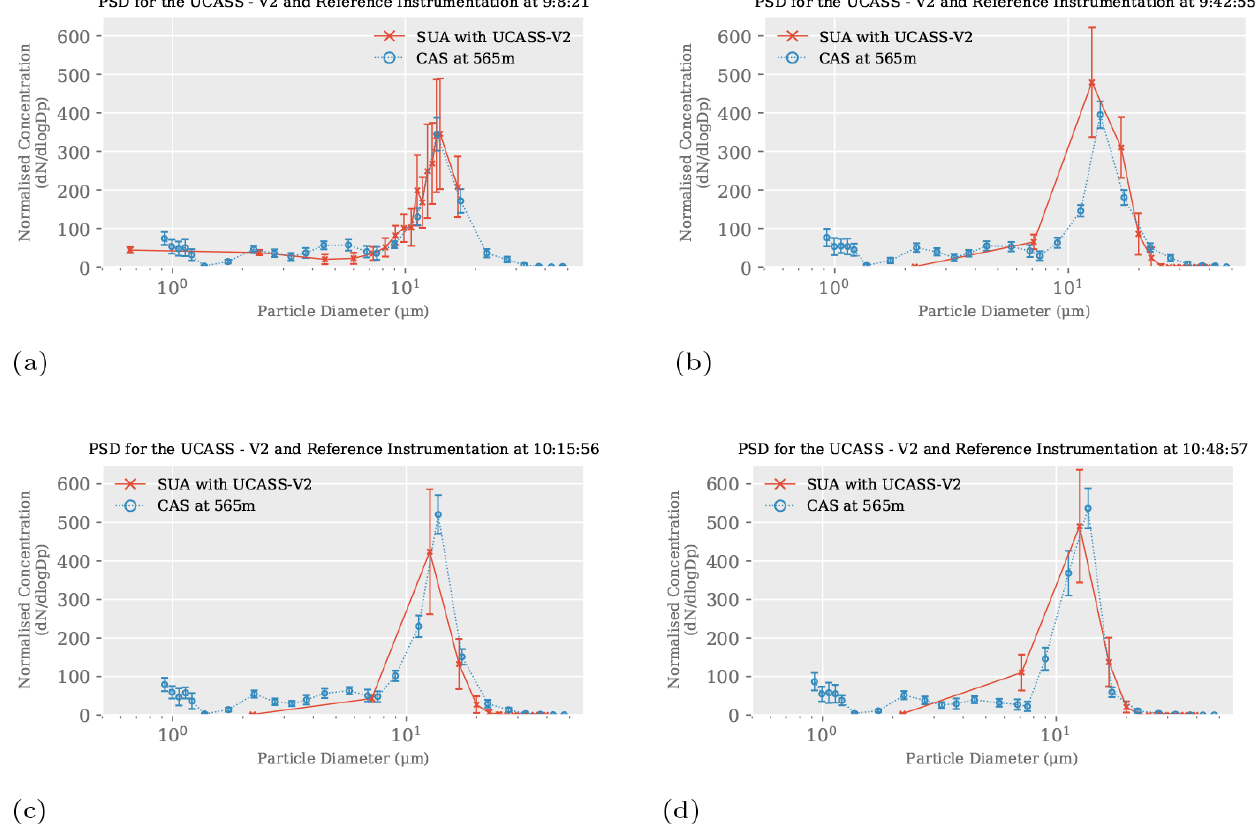
Figure 10. Normalised concentration plots for the SUA flights on 28 September 2019. The first flight in (a) was conducted in high-gain mode, where it was observed that the largest particle size was beyond the transimpedance amplifier saturation point. The remaining three flights, therefore, were conducted in low-gain mode to ensure larger droplets were